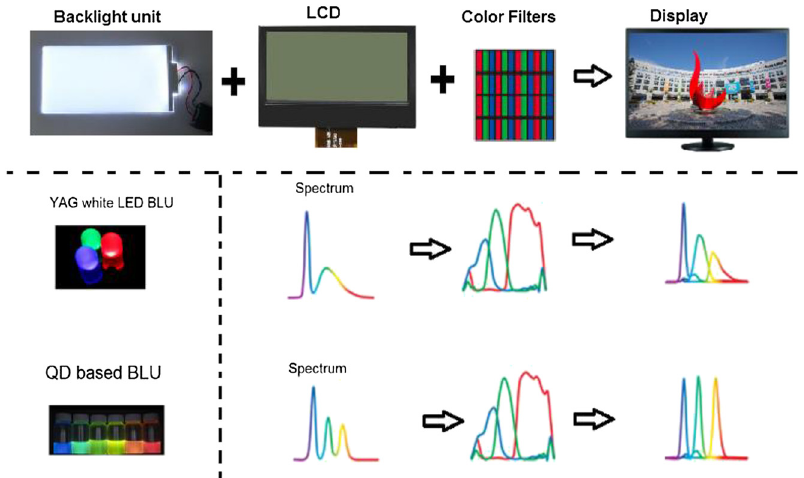
Figure 17: Comparison of LCDs equipped with different BLUs. (a) White light from the YAG based LED BLU passes through the LCD panel and color filters to produce the full-color image. (b) The light from QD-based BLU after passing through the LCD panel and color filters generates the full-color images with highly saturated